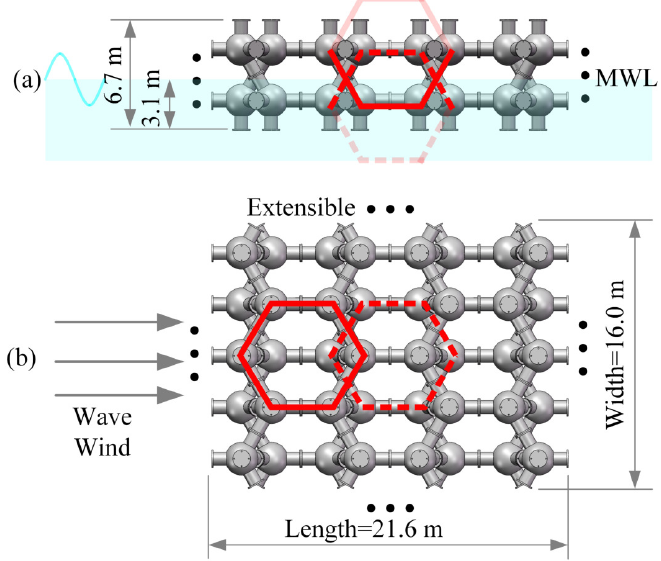
Figure 2. The BDFF with parameters D = 2.0 m, d = 0.8 m, h = 6.7 m, m = 4, n = 5. Three black dots means the model can be expanded freely in this direction. ( a ) The front view; ( b ) the top